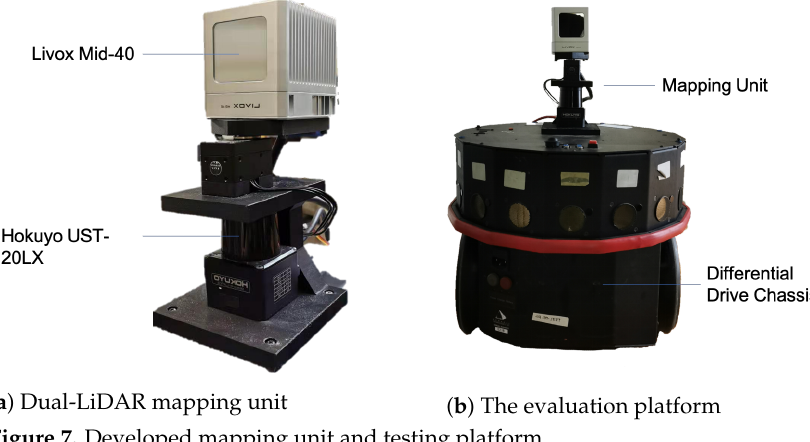
Figure 7. Developed mapping unit and testing